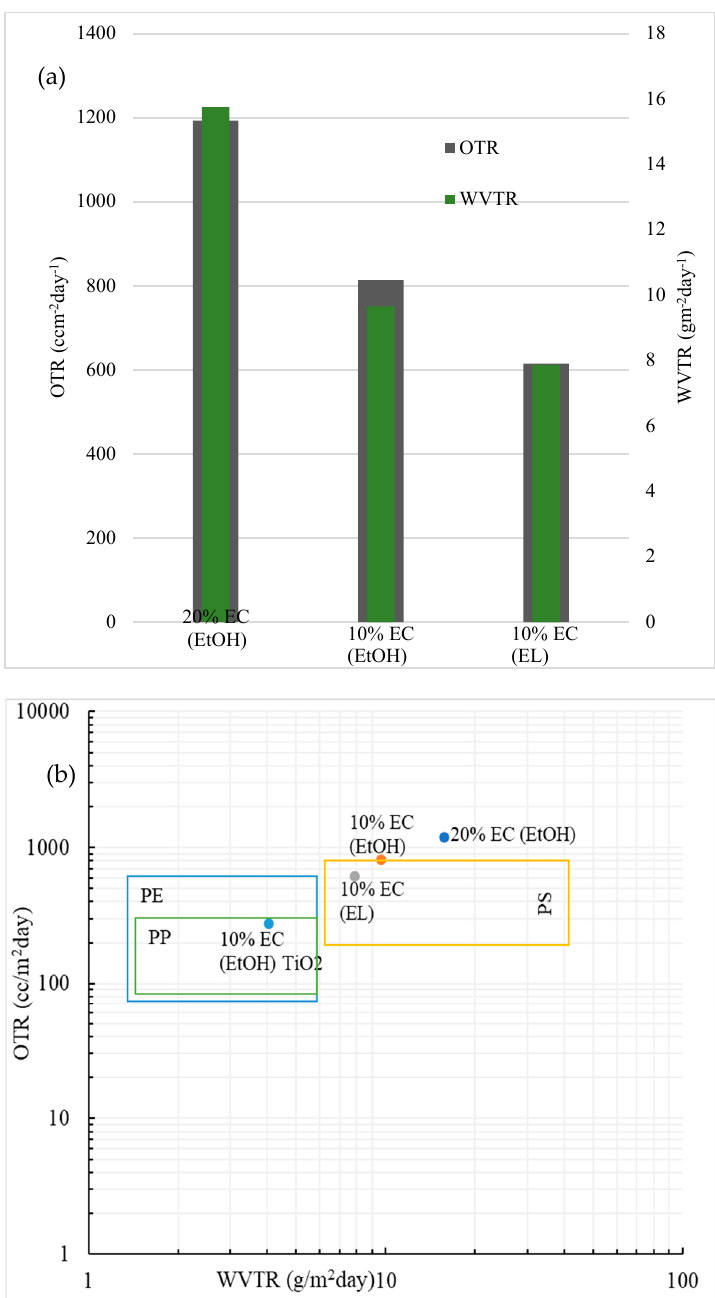
Figure 5. ( a ) Barrier performance of the prepared samples; normalized data for 60 μ m-thick films. ( b ) Comparison of the barrier performance of the prepared EC films in this study with those of some common polymers used in food packaging. Data are normalized for 60 μ m-thick films.